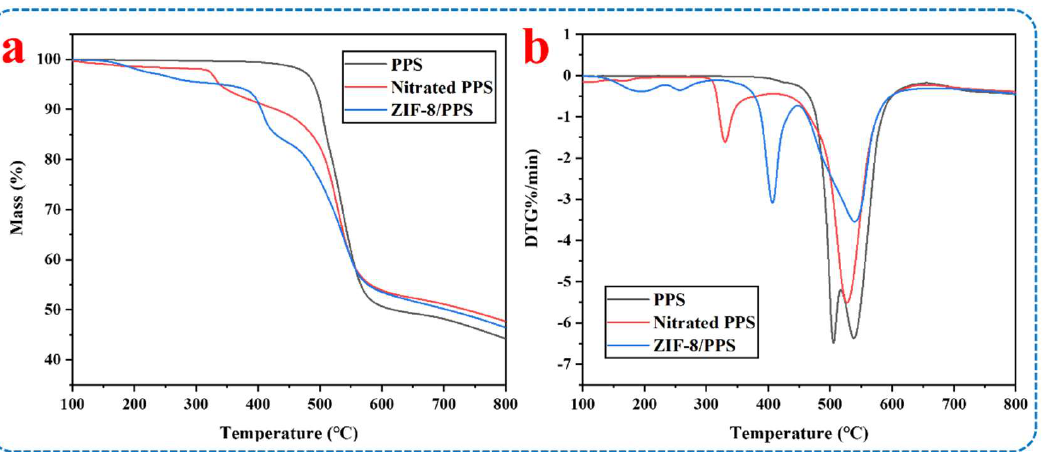
Figure 10. ( a ) TG curves of PPS non-woven fabrics, PPS non-woven fabrics after nitrification, and ZIF-8/PPS fiber membranes; ( b ) DTG curves of PPS non-woven fabrics, PPS non-woven fabrics after nitrification, and ZIF-8/PPS fiber membranes.